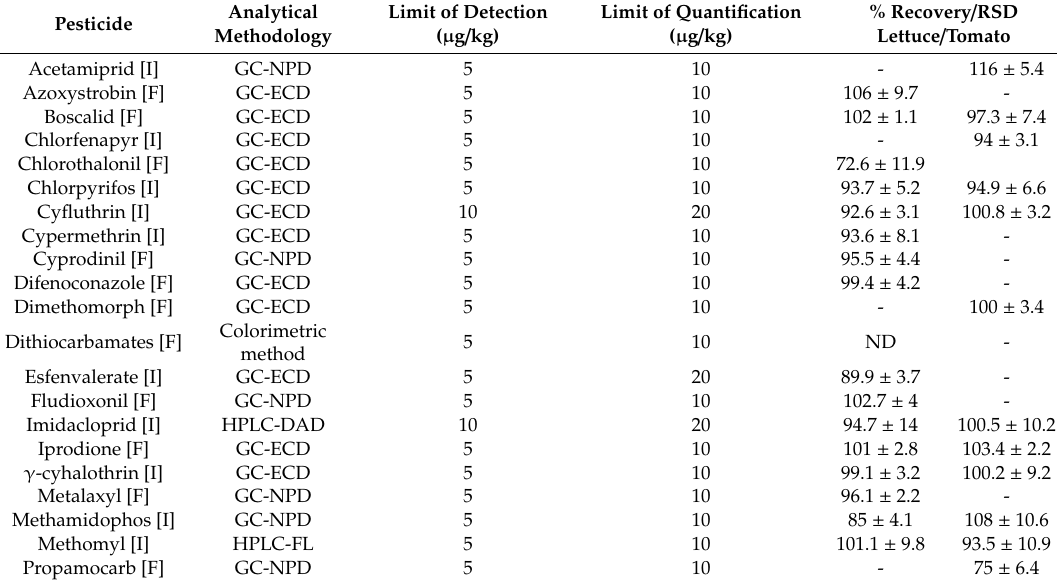
Table 1. Quality assurance parameters obtained for the analysis of the target pesticides ( n = 6).